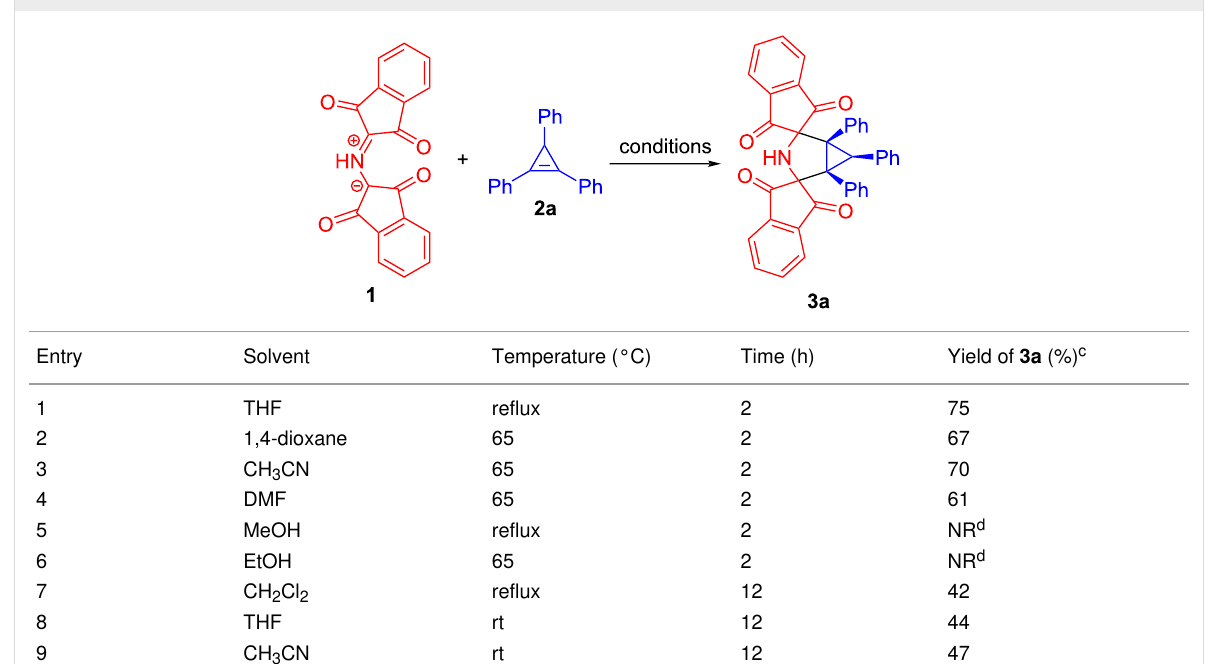
Table 1: Optimization of the reaction conditions a,b